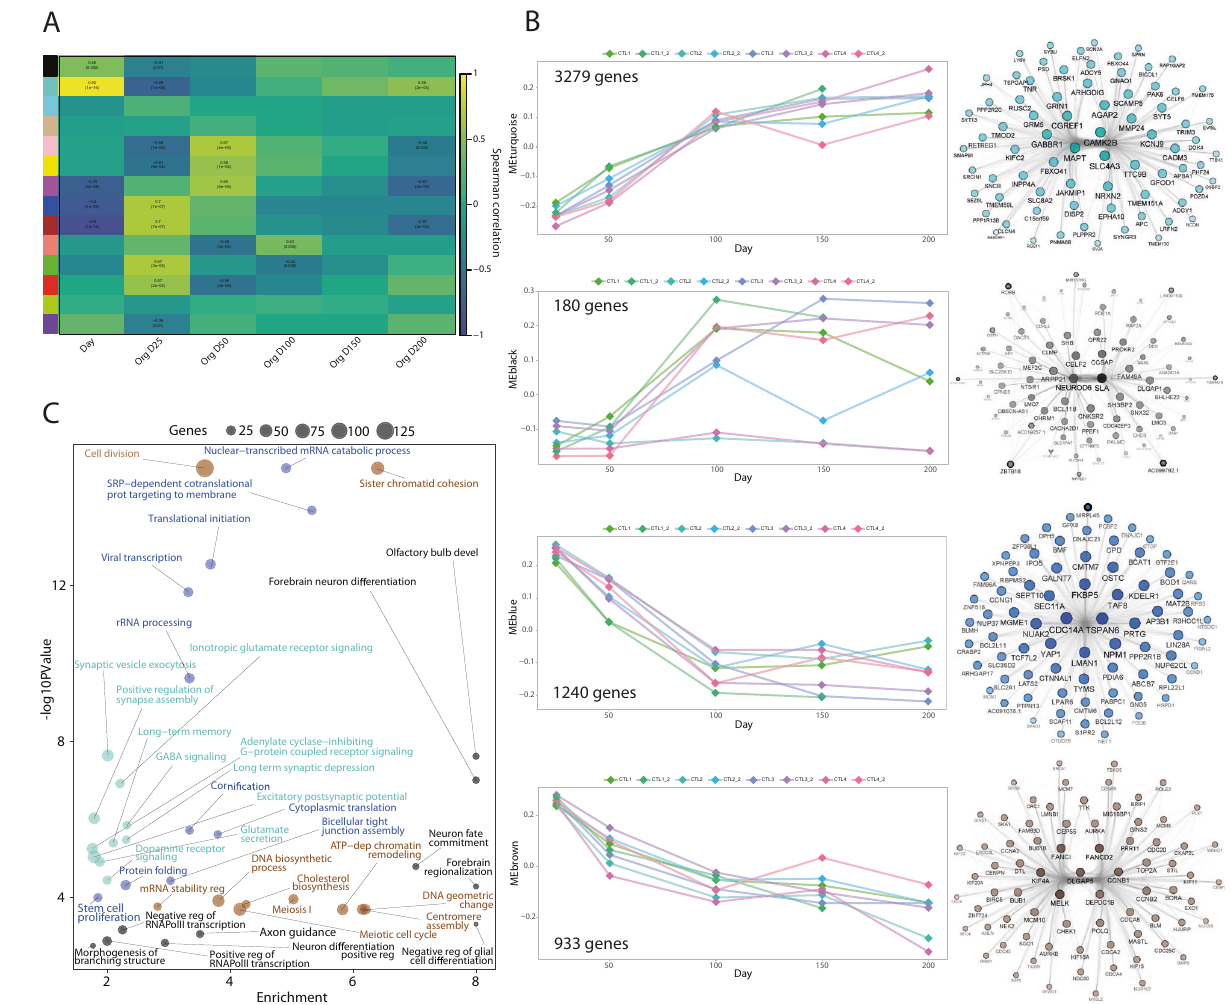
Fig. 3 Cortical brain organoids evolve towards the glutamatergic fate. A Heatmap showing the correlation between gene modules (summarized as ME) identi fi ed by WGCNA in cortical brain organoid (CBO) dataset and differentiation stage either as a continuous variable (Day) or a categorical variable for each time-point. Correlation coef fi cient and P -values are reported for signi fi cant correlations (Spearman P -value < 0.01). B Characterization of CBO_Turquoise, CBO_Black, CBO_Blue, and CBO_Brown gene modules. For each module, the ribbon plot visualizes the behavior of the module eigengene throughout differentiation time-points; each dot represents a data point, while the line connects time points of the same replicate (line and differentiation batch). Network reconstruction for the top-75 genes of each module, selected according to the intramodular connectivity value. Degree, closeness, betweenness, and eigenvector are represented by node label transparency, node color darkness, node border width, and node size/node label font size, respectively. Node shape represents gene biotype, with protein-coding genes as circles. C Bubble plot depicting the results of GO enrichment analysis for the four modules: P -values and enrichment scores are reported (details are reported in Supplementary Table which RNAseq was publicly available. These datasets of archetypal again at late stages. Both modules were enriched in genes related BO protocols, different for degree of guidance and culture to cell adhesion and ECM organization (Supplementary Fig. 6D, E). conditions, included samples at comparable time-points (from 0 In summary, we time-resolved the transcriptional evolution of to 100 days). The selected BO datasets were: (i) minimally-guided CBO by identifying co-expression patterns and transcriptional neural organoids (MGO) [14]; (ii) forebrain organoids (FO) [20]; (iii) hubs driving their differentiation. We generated a knowledge base telencephalic aggregates (TA) [21], including a fi rst step of 2D that classi fi es genes in distinct modules of behavior along differentiation (Fig. 4A and Supplementary Fig. 7). organoid differentiation and links them to speci fi c functional Stage-wise DEA revealed also for MGO, FO, and TA a decrease in domains. We found overall consistency among lines from the number of DEGs as differentiation progresses (Fig. 4B). independent individuals and replicates. Main modules, their However, the slow-evolving phase, which started between day behavior, and relevance of every gene composing them are 100 – 150 in CBO (Fig. 2C), was anticipated for all other protocols available in Supplementary File 2. (day 40 – 60) (Fig. 4B). We then compared the DEGs identi fi ed for each stage transition in each external BO dataset to those Benchmarking of brain organoids against prenatal human retrieved for CBO (Supplementary Fig. 8A – C). The results high- corticogenesis reveals heterochronicity of differentiation lighted a similarity in the transcriptional evolution of the models, across protocols with a high degree of overlap especially for MGO. In line with DEA, To compare CBO against other protocols and evaluate them we found a more compressed time frame in the evolution of the versus the fetal cortex, we selected three external BO datasets for